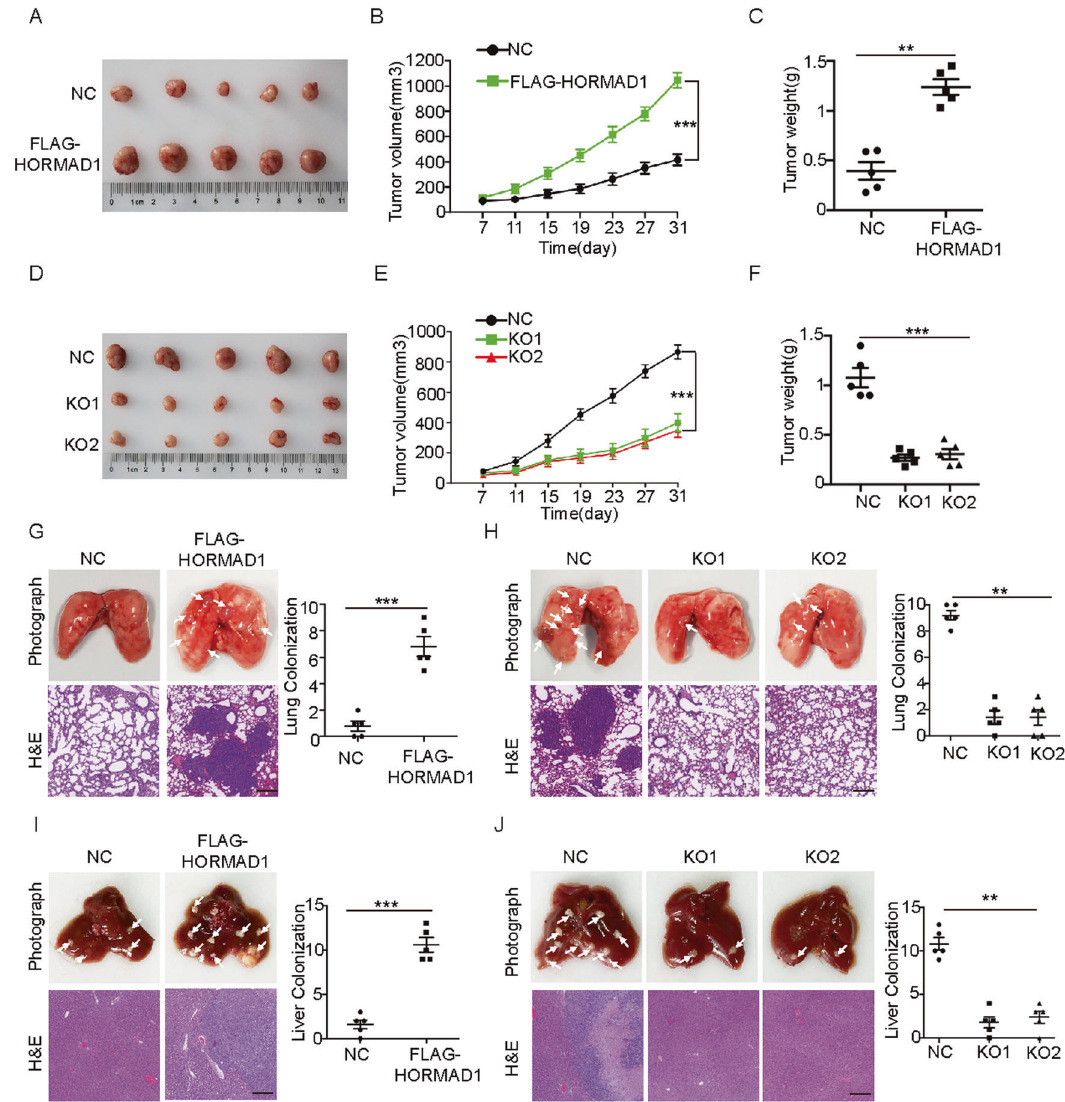
Fig. 3 HORMAD1 promotes tumor growth and metastasis in vivo. A Photographs of xenografts tumors from each nude mouse in the H157- HORMAD1 group and vector control group. n = 5. B Tumor growth curves for the H157-HORMAD1 group and vector control group at the indicated times. n = 5. C Tumor weights in the H157-HORMAD1 group and vector control group. n = 5. D Photographs of xenografts tumors from each nude mouse in the H650-NC and H650-HORMAD1 KO groups. n = 5. E Tumor growth curves for the H650-NC and H650-HORMAD1 KO groups at the indicated times. n = 5. F Tumor weights in the H650-NC and H650-HORMAD1 KO groups. n = 5. Representative gross appearance of the lungs (upper) in the H157-HORMAD1 group and vector control groups ( G ) and the H650-NC and H650-HORMAD1 KO groups ( H ); H&E staining of lung metastases (lower) and quanti fi cation of lung metastatic nodules (right). The metastatic nodules are indicated by arrows and scale bars are 200 μ m. n = 5. Representative gross appearance of the livers (upper) in the H157-HORMAD1 group and vector control groups ( I ) and the H650-NC and H650-HORMAD1 KO groups ( J ); H&E staining of liver metastases (lower) and quanti fi cation of liver metastatic nodules (right). The metastatic nodules are indicated by arrows and scale bars are 200 μ m. n = 5. Mean ± SEM from three independent experiments are shown. ** p < 0.01; *** p <